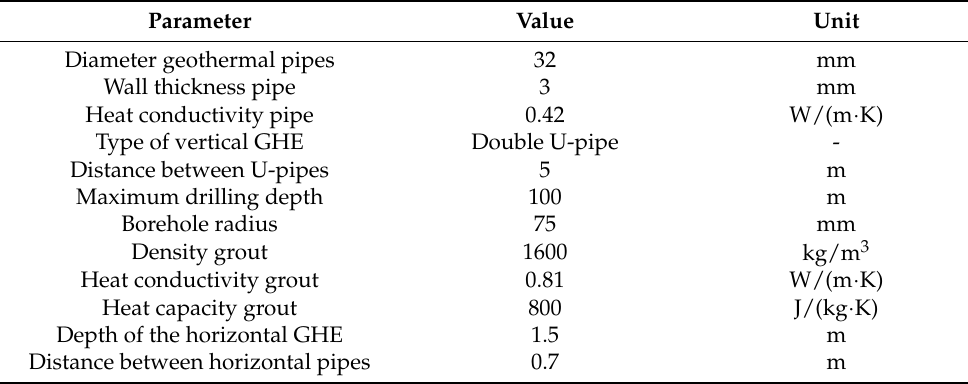
Table 5. Physical parameters used for modelling the ground heat